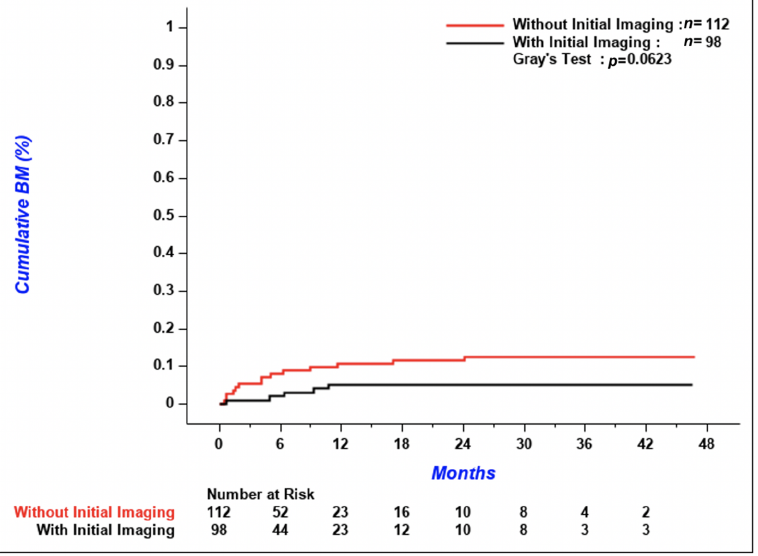
Figure 3. Cumulative incidence of metachronous brain metastases. BM = brain metastases.